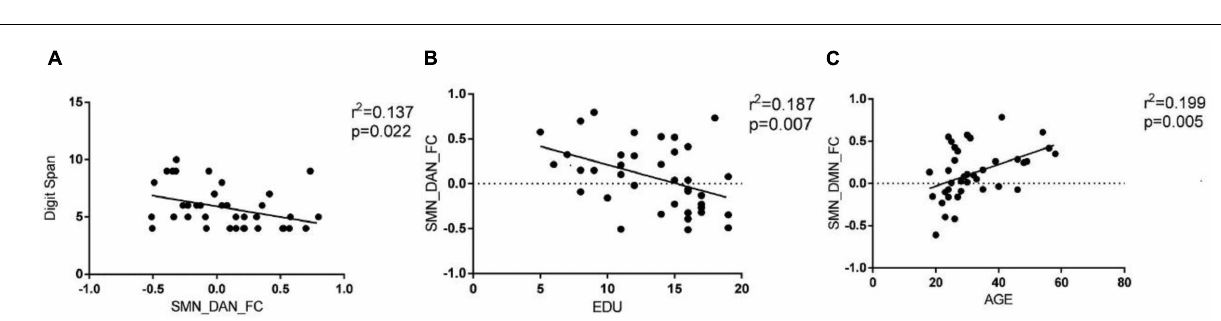
FIGURE 4 | Pearson correlation analysis of internetwork functional connectivity value and clinical information. (A) Digit span forward scores of all participants were negatively correlated with FC between SMN and DAN ( P < 0.05). (B) Education years of all participants were negatively correlated with FC between SMN and DAN ( P < 0.05). (C) Age of all subjects was positively correlated with FC between SMN and DMN ( P <